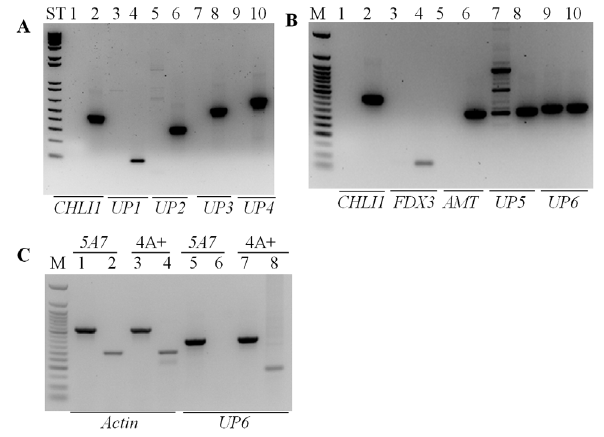
Figure 6. PCR analyses using primers specific to eight genes neighboring the CHLI1 locus. ( A ) PCR using the genomic DNA of 5A7 and 4A+ with primers specific to CHLI1 and four neighboring genes ( UP1 , UP2 , UP3 , UP4 ) downstream of the CHLI1 gene. The sizes of the genomic DNA PCR products for CHLI1 , UP1 , UP2 , UP3 and UP4 are, 459, 100, 342, 550 and 672 (bp), respectively. Odd numbered lanes denote 5A7 ; even numbered lanes denote 4A+; ST denotes 1 kb plus DNA ladder. ( B ) PCR using the genomic DNA of 5A7 and 4A+ with primers specific to CHLI1 and four neighboring genes ( FDX3 , AMT , UP5 and UP6 ) upstream of the CHLI1 gene. The sizes of the genomic DNA PCR products for CHLI1 , FDX3 , AMT , UP5 and UP6 are, 459, 90, 369, 379 and 369 (bp), respectively. Odd numbered lanes denote 5A7 ; even numbered lanes denote 4A+; M denotes 50 bp DNA ladder (NEB, Beverly, MA). ( C ) PCR and RT-PCR with UP6 gene specific primers using the 5A7 and 4A+ genomic DNA and cDNA. Actin was used as a control. Actin genomic and cDNA product sizes are 527 and 305 (bp), respectively. Odd numbered lanes denote genomic DNA PCR products; even numbered lanes denote cDNA products. All primers used spanned an intron. M denotes 50 bp DNA ladder. All DNA samples were run on a 1.8% agarose gel. Gene names are given at the bottom of the gel. Primer sequences are shown in Table 2 and Table 3.